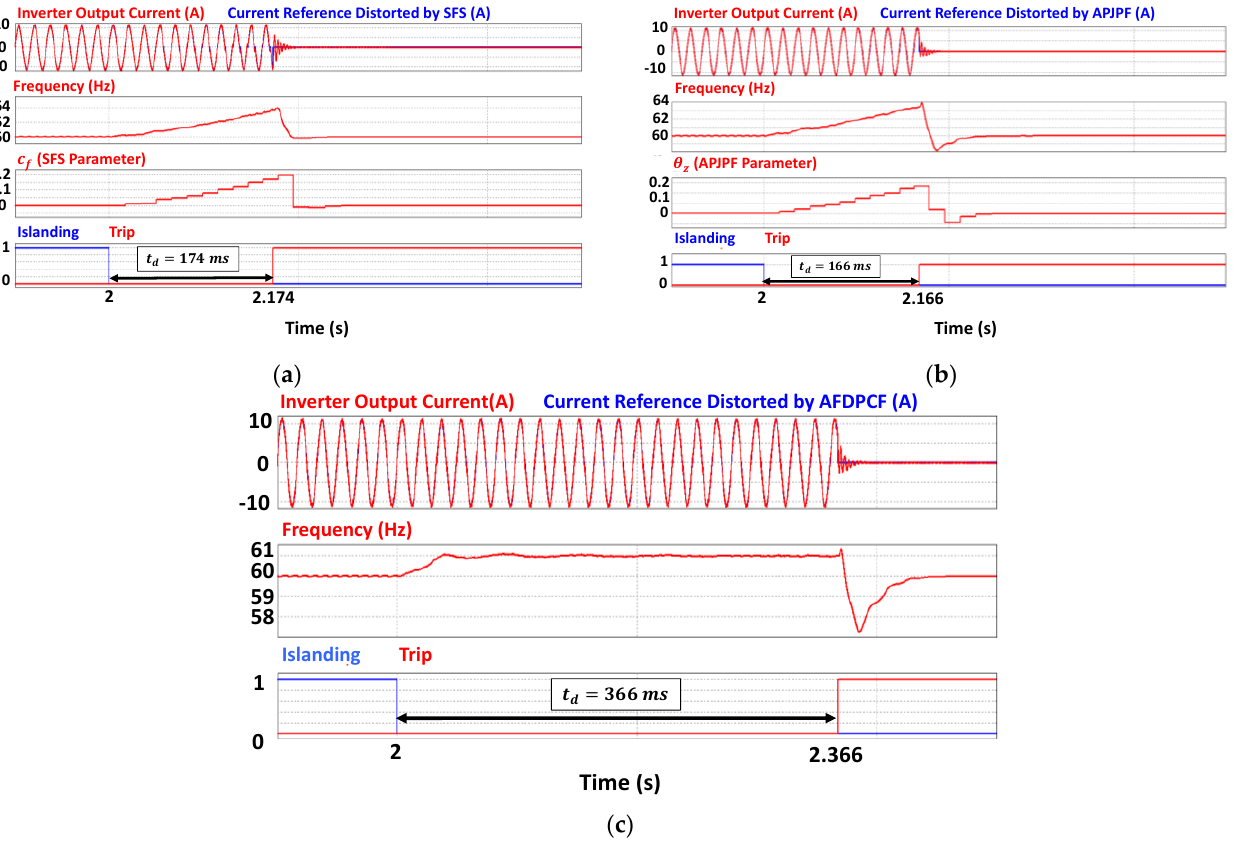
Figure 17. Current, frequency, “Islanding”, and “Trip computational results for C norm = 1 ( a ) under SFS implementation; ( b ) under the APJPF implementation; ( c ) under the AFDPCF implementation.